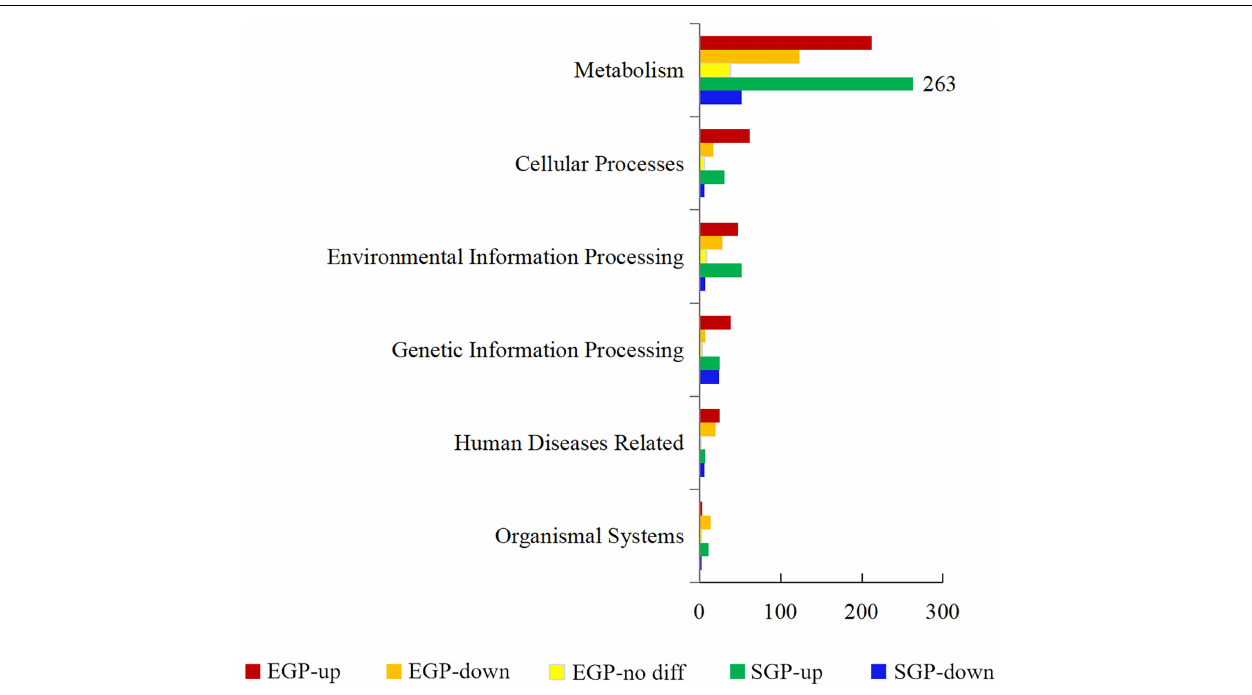
FIGURE 4 | Enrichment hierarchies of differentially expressed genes (DEGs) in strain ST7 under manganese stress. The horizontal ordinate represents the number of enriched genes in each hierarchy. Numbers of enriched DEGs that were upregulated, downregulated, and without difference in exponential growth phase (EGP) are indicated as EGP-up (the upregulated DEGs at EGP), EGP-down (the downregulated DEGs at EGP), and EGP-no diff (genes with no significance at EGP), respectively. Numbers of DEGs that were upregulated and downregulated in stationary growth phase (SGP) are shown as SGP-up (the upregulated DEGs at SGP) and SGP-down (the downregulated DEGs at SGP), respectively.